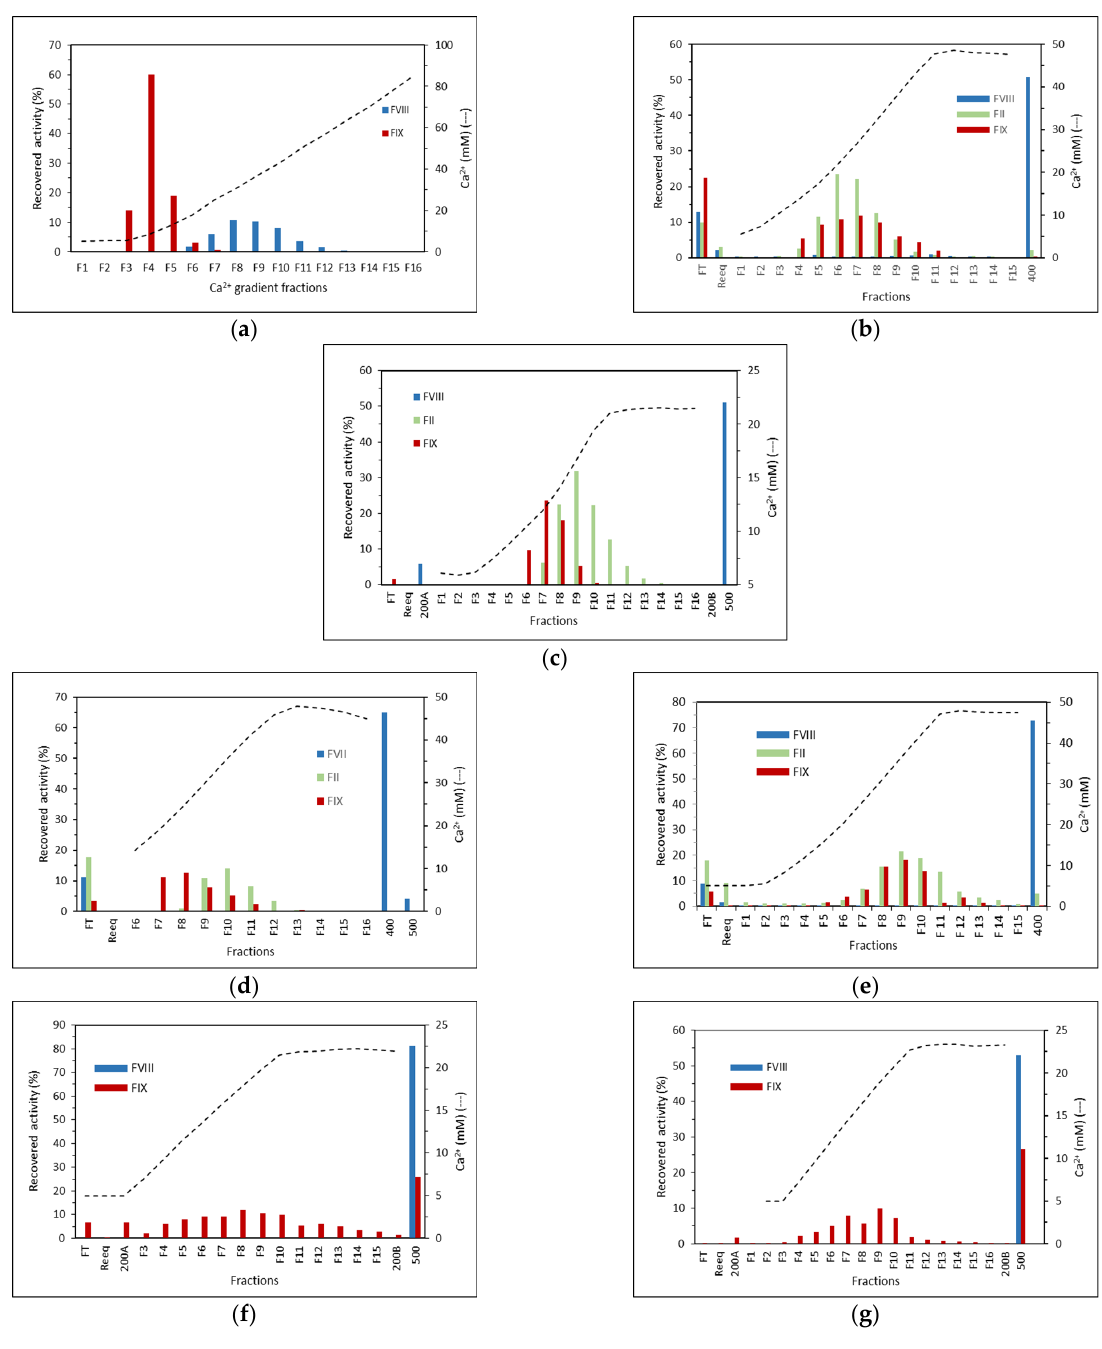
Figure 2. ( a ) FVIII and FIX recovered activities on the chromatography of plasma on Q Sepharose FF with 5 to 100 mM linear CaCl 2 gradient and citrate buffer; ( b ) FVIII, FII and FIX recovered activities on the chromatography of plasma on Fractogel EMD TMAE with 5 to 50 mM linear CaCl 2 gradient and citrate buffer; ( c ) FVIII, FII and FIX recovered activities on the chromatography of plasma on ANX Sepharose FF, 5 to 25 mM linear CaCl 2 gradient and citrate buffer; ( d ) FVIII, FII and FIX recovered activities on the chromatography of plasma on DEAE Sepharose FF, 5 to 50 mM linear CaCl 2 gradient and citrate buffer; ( e ) FVIII, FII and FIX recovered activities on the chromatography of plasma on Fractogel EMD DEAE with 5 to 50 mM linear CaCl 2 gradient and citrate buffer; ( f ) FVIII and FIX recovered activities on the chromatography of plasma on ANX Sepharose FF, 5 to 25 mM linear CaCl 2 gradient and Bis-tris buffer; and ( g ) FVIII and FIX recovered activities on the chromatography of plasma on ANX Sepharose FF, 5 to 25 mM linear CaCl 2 gradient and MES